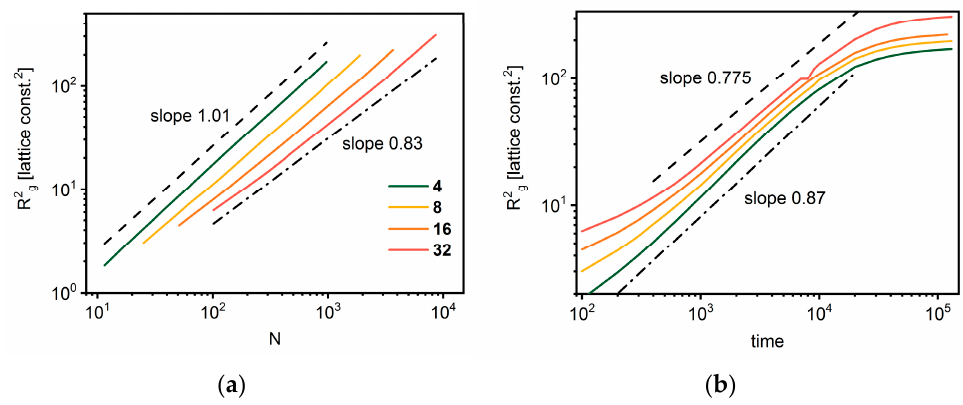
Figure 10. The mean-squared radius of gyration < R g 2 > of star-branched chains as a function of total number of beads N ( a ) and as a function of time ( b ). The colors indicate the number of arms.